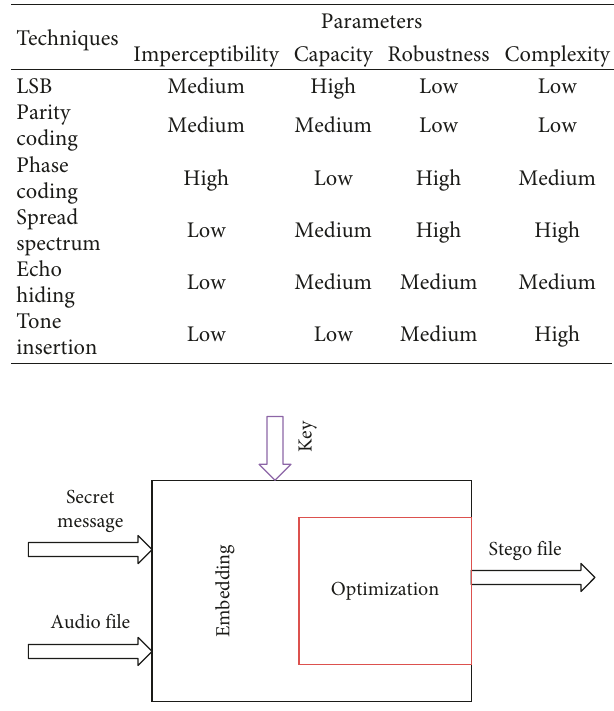
Figure 1: Proposed solution